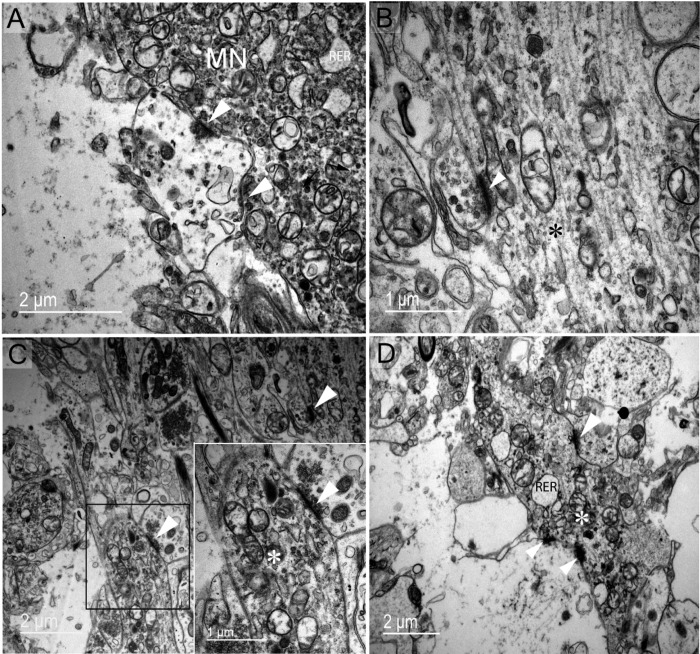
Common synaptic innervations types found in the supraoptic nucleus.(A) Axo-somatic active synapses (arrowheads) were in contact with magnocellular neurones in an active functional stage, according to the cytoplasmic subcellular appearance, especially the dilated rough reticulum endoplasmic. (B) Axo-axonic synapse (arrowhead) (asterisk represents an magnocellular neurone axon). (C) Axo-dendritic synapse (arrowhead) (square magnified in the right) (asterisks represent a dendrite from a magnocellular neurone). (D) In the dendritic zone, multiple axo-dendritic synapses (arrowheads) (asterisk represents a dendrite from a magnocellular neurone) are seen. Note the dilation stage of rough reticulum endoplasmic reticulum (RER).